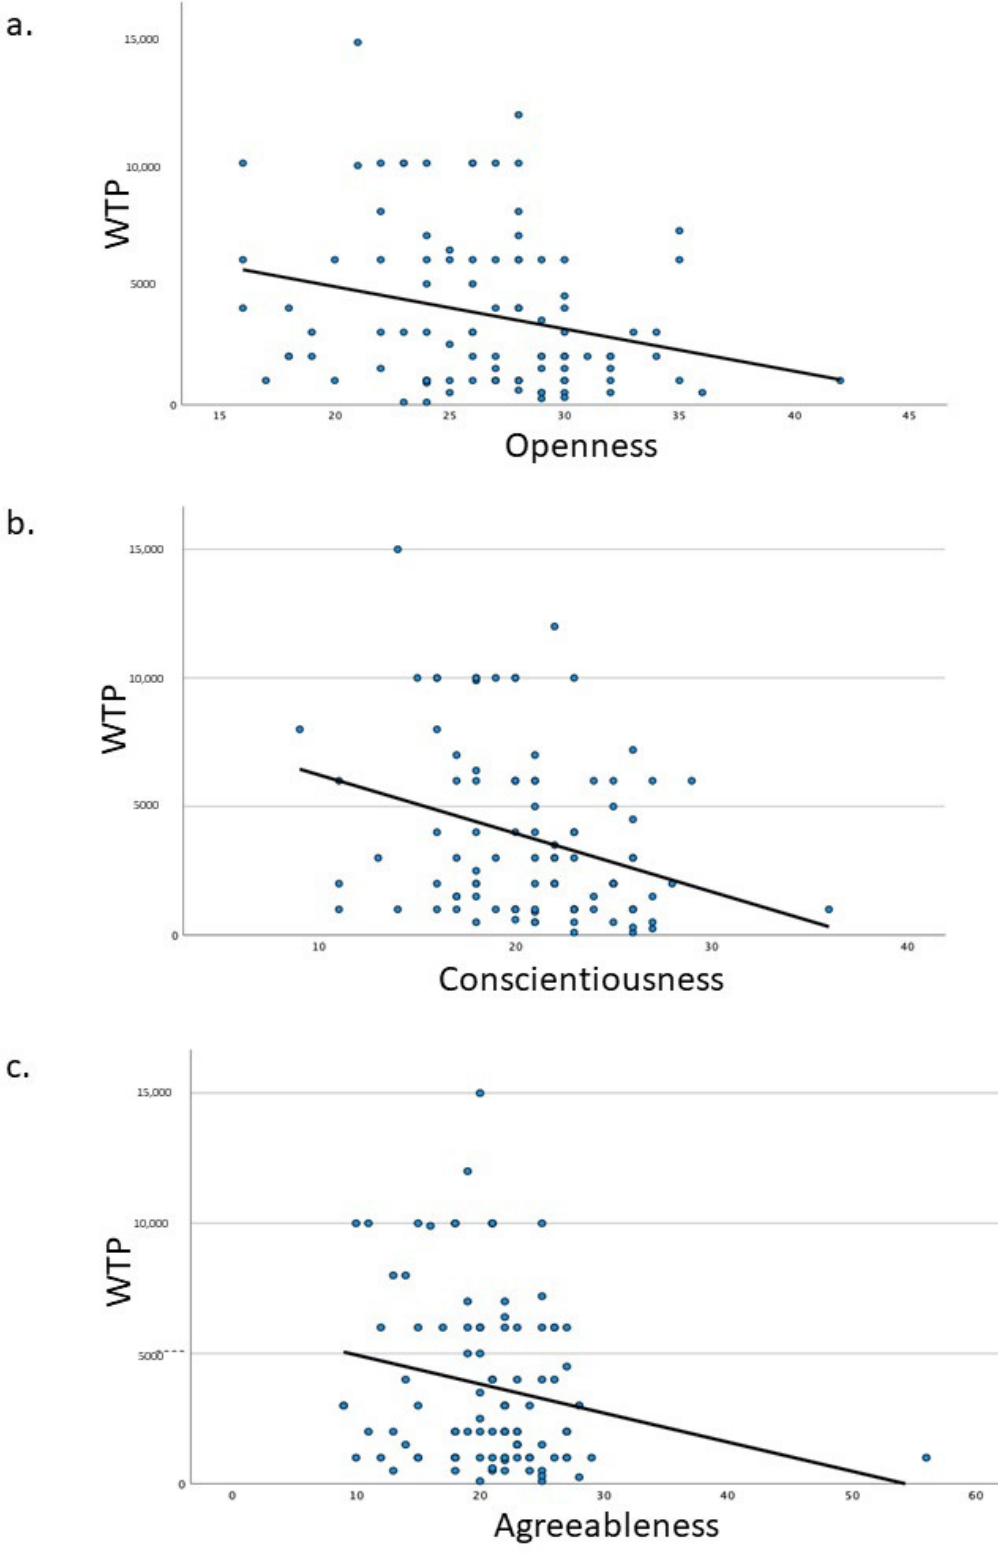
Figure 2. Correlation of personality traits to willingness to pay. ( a ) Openness, ( b ) Conscientiousness, ( c )